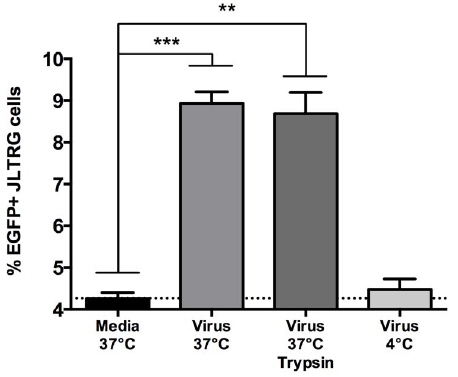
Figure 4. Astrocytes are capable of trans -infection. FACS analysis of EGFP expression in JLTRG cells following co-culture with SVG cells loaded with virus under different conditions (37 u C, 37 u C followed by trypsin treatment, or 4 u C). Media treated cells were included as a negative control for background fluorescence in the JLTRG cells. The data are expressed as mean values and error bars represent standard deviation. Data are a compilation of three independent experiments. P values were calculated using a parametric unpaired t test; ***, P =0.0005; **, P =0.001.